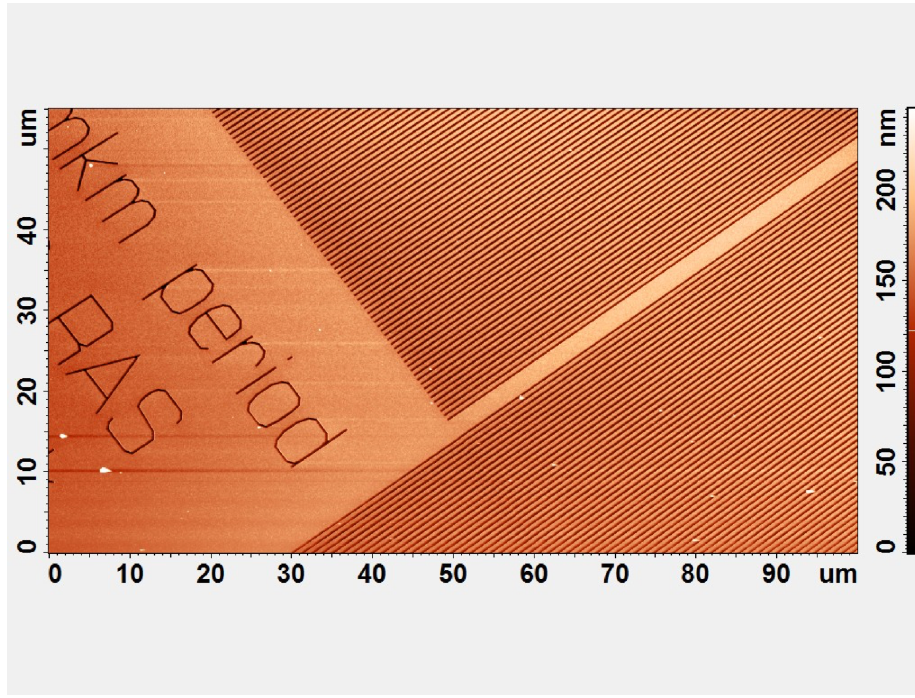
Figure 15. AFM of periodic dielectric structures based on Au and PMMA. The period equals 670–680 nm, gold thickness equals 40nm, reprinted with permission from [16], the Optical Society (OSA).